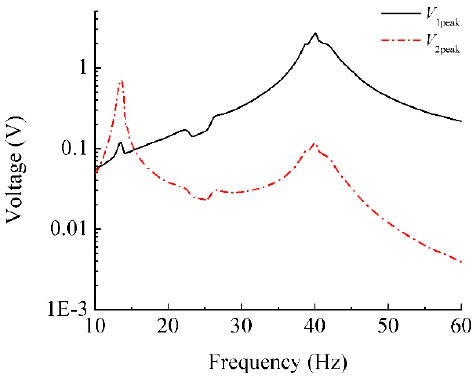
Figure 11. Sweep spectrum analysis for the output voltage frequency responses of the FUCHEH.